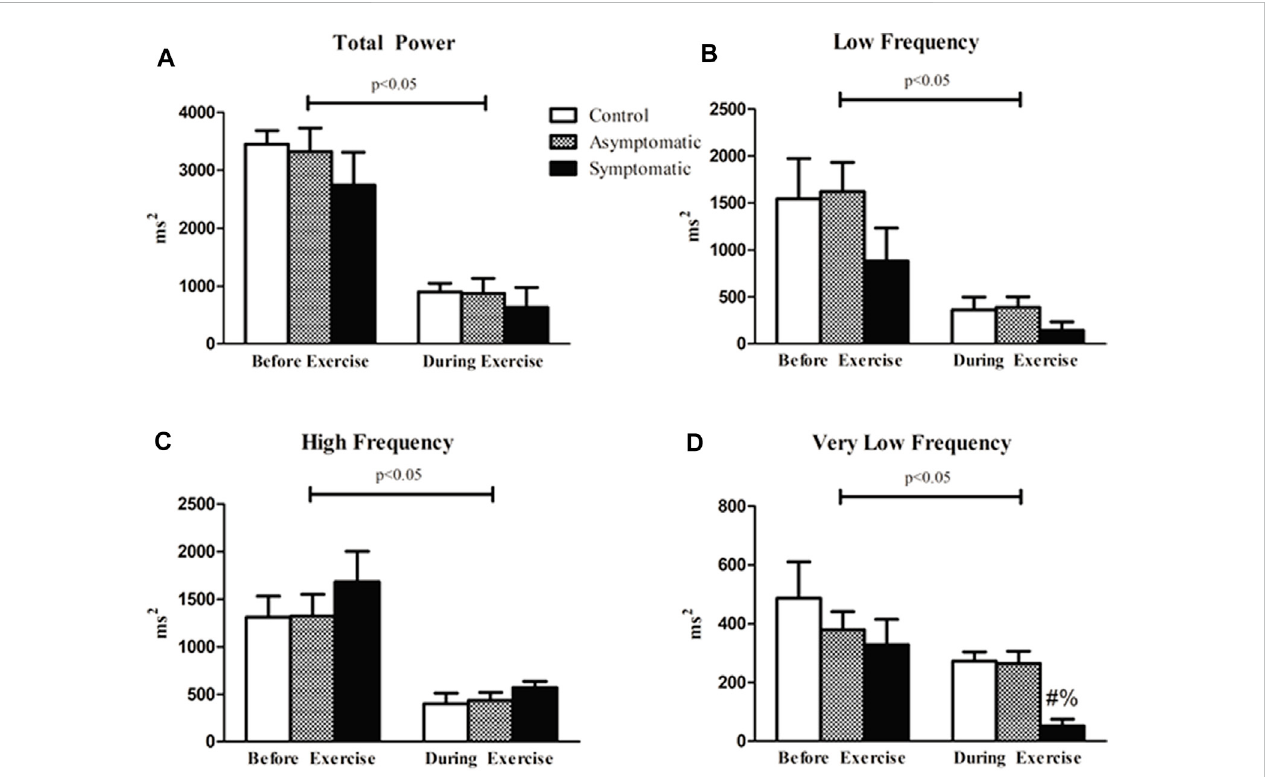
Spectral analysis of HRV revealed that there was an effect of exercise in all four variables. However, there was no difference between groups for (A) total power (TP) both before and after exercise. (B) High frequency (HF) and (C) low frequency (LF) bands were not different between our groups. (D) Very low